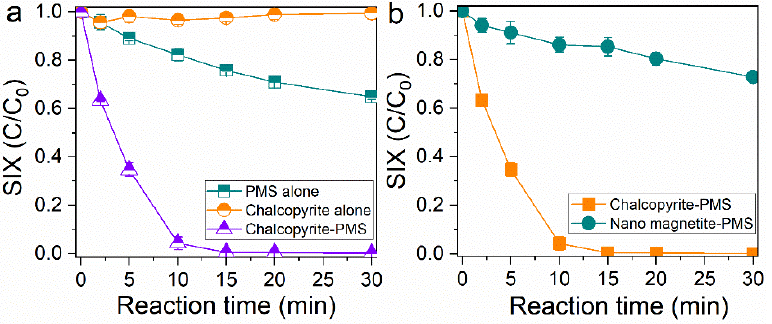
Figure 1. ( a ) Degradation of SIX by chalcopyrite–PMS oxidation and ( b ) reactivity of different activators. Conditions: [SIX] = 5 mg/L, [PMS] = 0.5 mM, [chalcopyrite] = [magnetite] = 1 g/L, and pH 3.0.